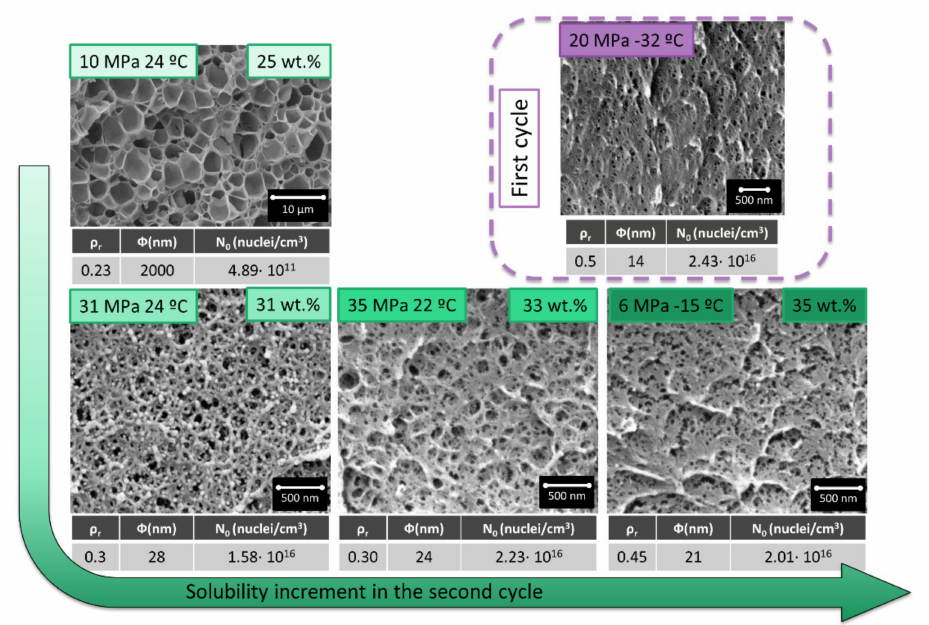
Figure 5. Cellular structures obtained at different saturation conditions in the second cycle (10 MPa 25 ◦ C, 30 MPa 25 ◦ C, 35 MPa 22 ◦ C and 6 MPa − 15 ◦ C and foamed at 80 ◦ C for 1 min) by fixing the saturation parameters in the first cycle at 20 MPa and − 32 ◦ C and foamed at 60 ◦ C for 1 min. Those results can be deeply analyzed by measuring the relative density, cell size, and cell nucleation density (Figure 6). The dashed line in Figure 6 indicates the values for a material produced in a single cycle at 20 MPa − 32 ◦ C, with a cell size of 14 nm, a cell nucleation density of 2.43 × 10 16 nuclei/cm 3, and a relative density of 0.5. As previously commented, those cell size values are the smallest reported in the literature for PMMA, with a relative density of